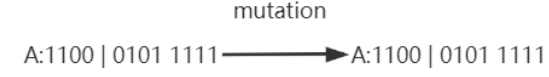
Figure 6. Mutation operation.